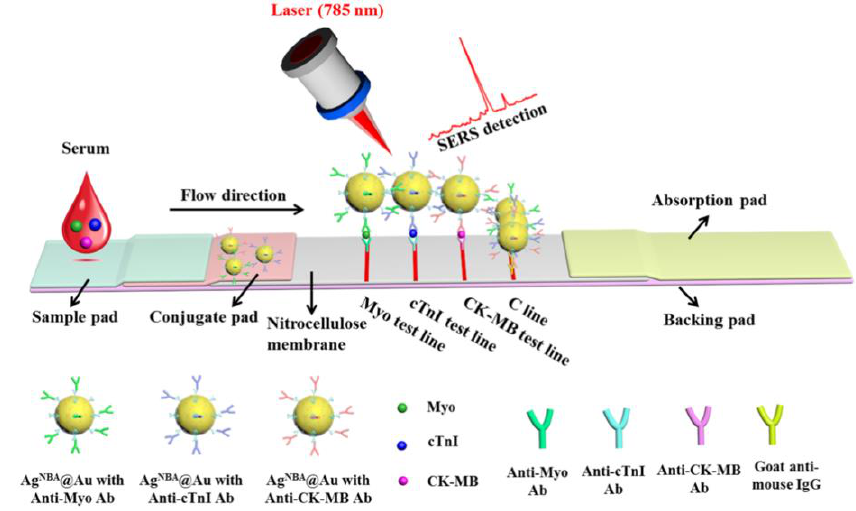
Figure 7. Diagram of a SERS lateral flow assay used to achieve multiplex detection [176] (Figure was re-printed with permission from the publisher).